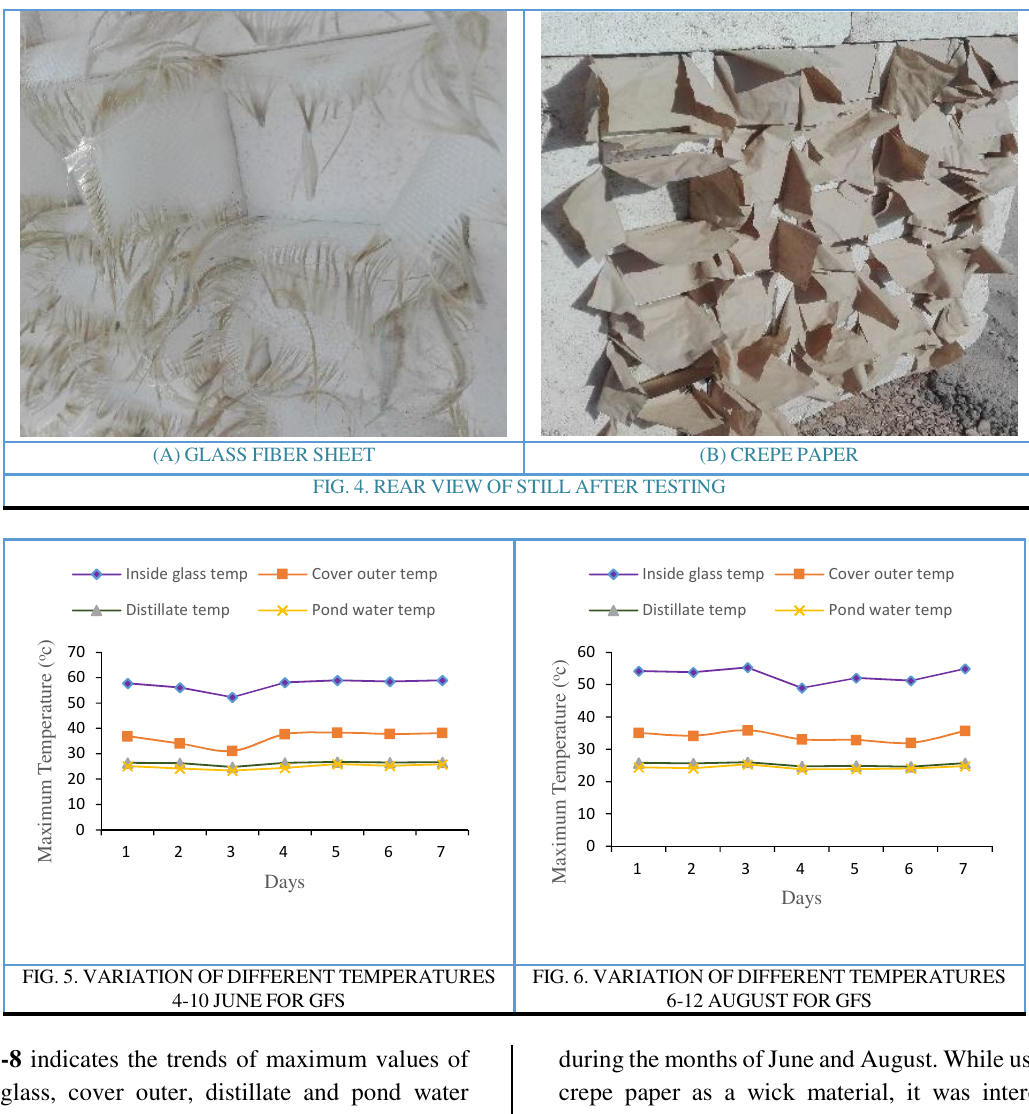
FIG. 5. VARIATION OF DIFFERENT TEMPERATURES 4-10 JUNE FOR GFS